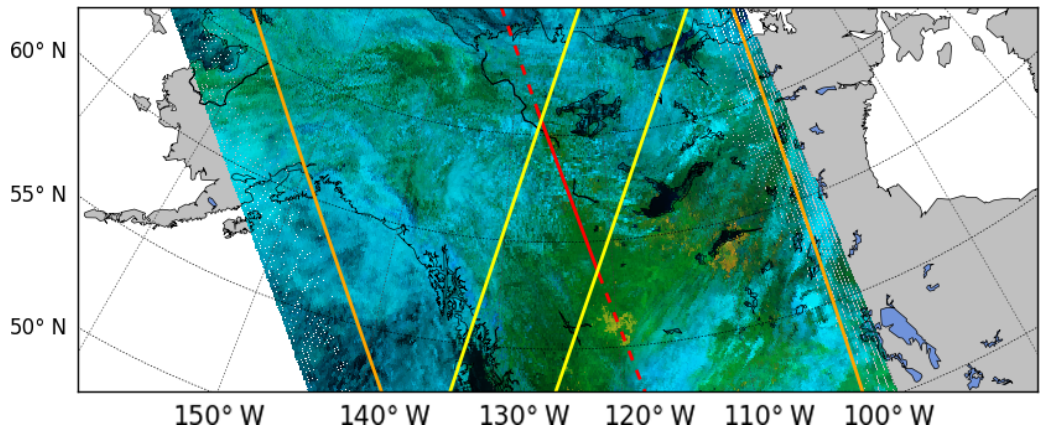
Figure 11. Study area NA2 (North America 2). As Fig. 9, but on 22 July 2008, at 20:58LST.